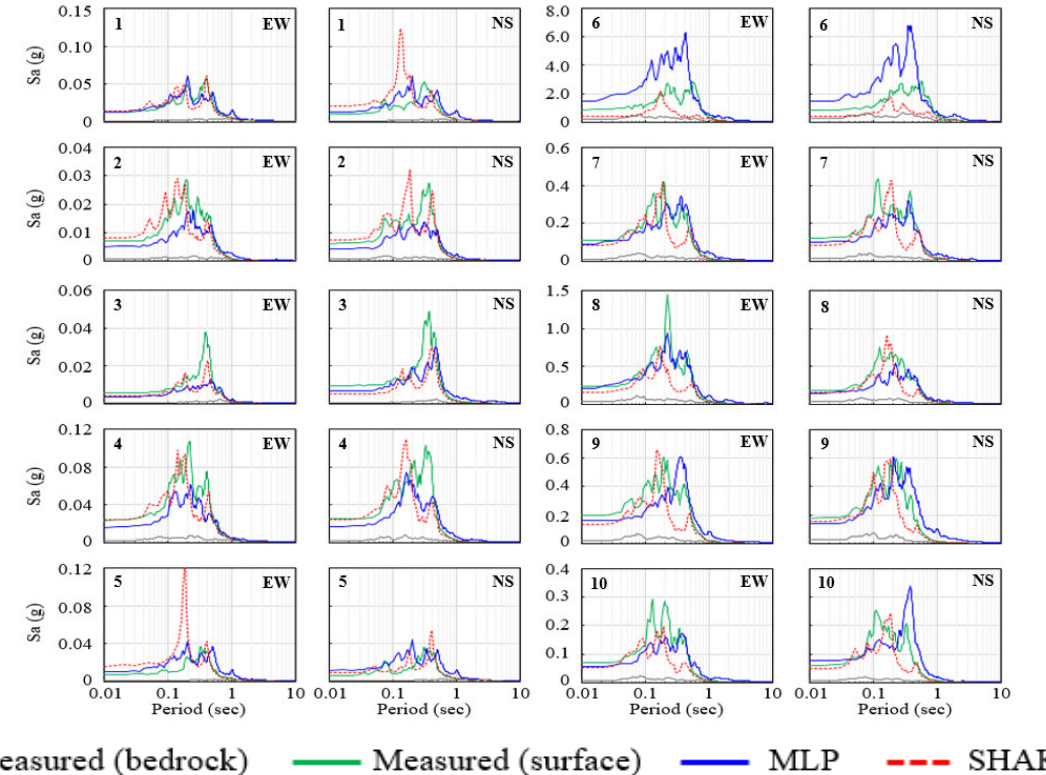
Figure 8. Measured, predicted, and computed response spectra at FKSH18 for east–west and north–south directions.